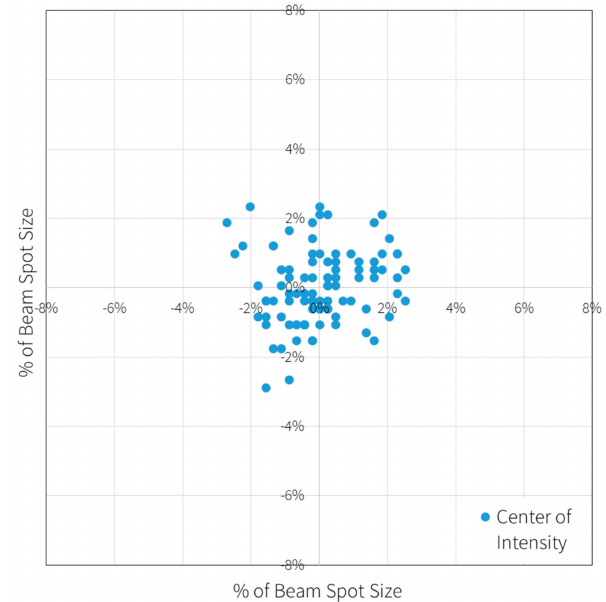
Figure 7. Movement of the focus spot relative to the beam size at the fiber output while moving the fiber in an application.